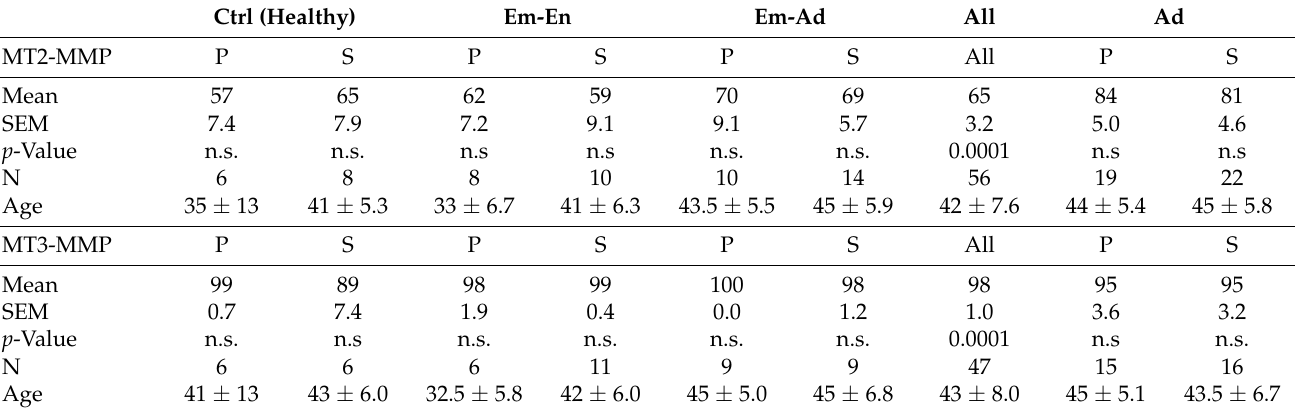
Table 4. Comparison of MT2/3-MMP in proliferative and secretory phases of endometrium of patients with and without endometriosis and adenomyosis using the percentage of stained glands. Em-En Em-Ad All